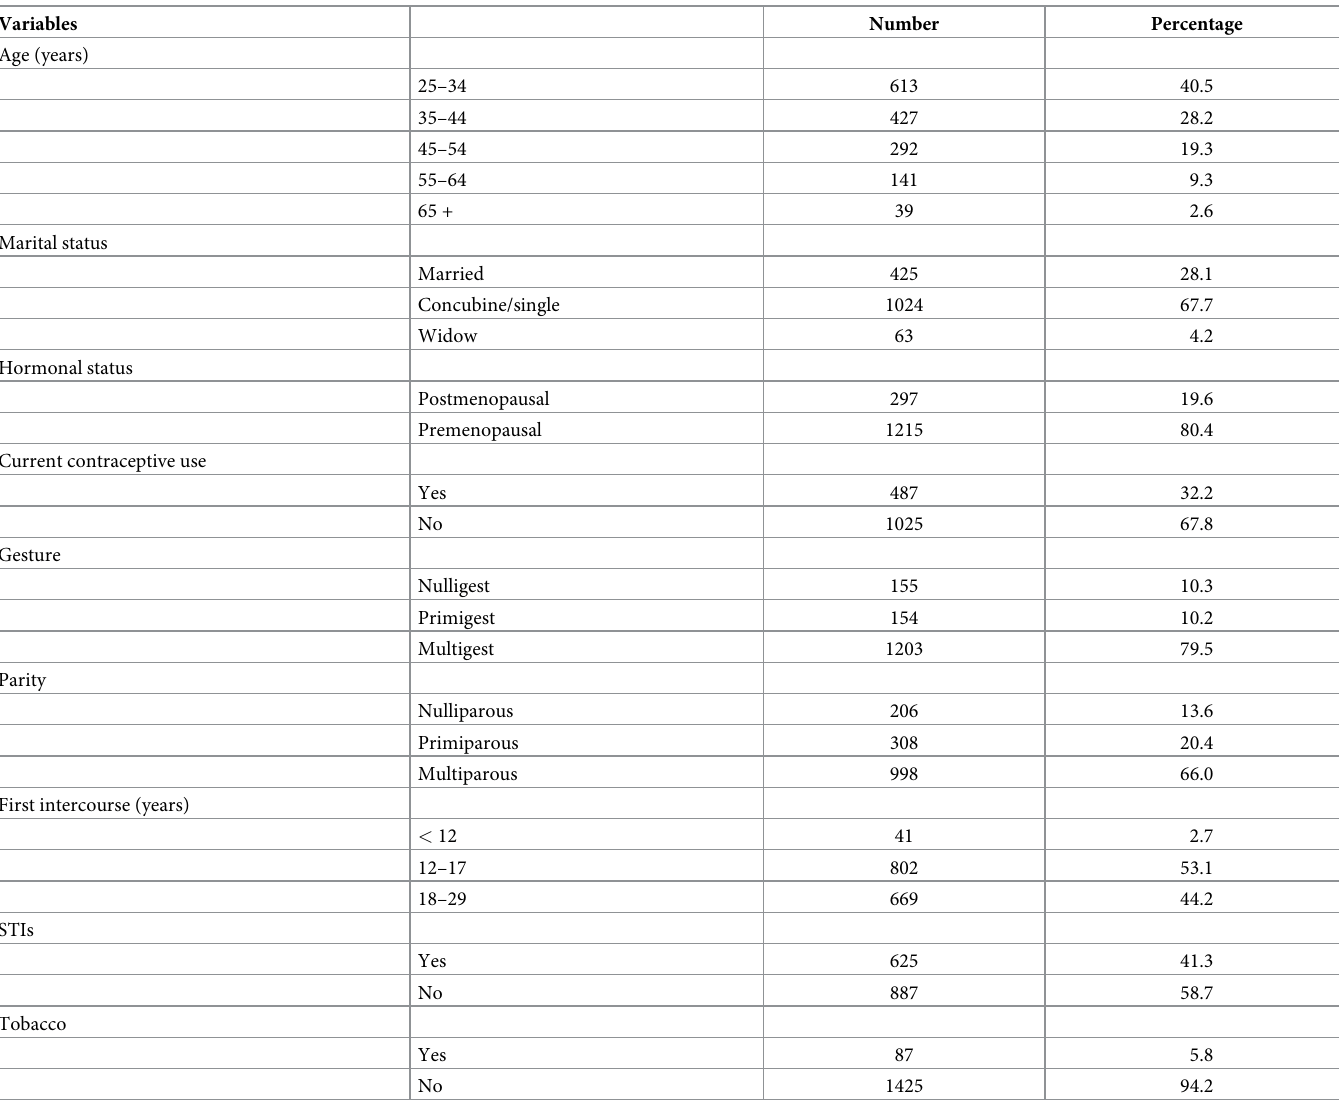
Table 1. Sociodemographic and medical characteristics of